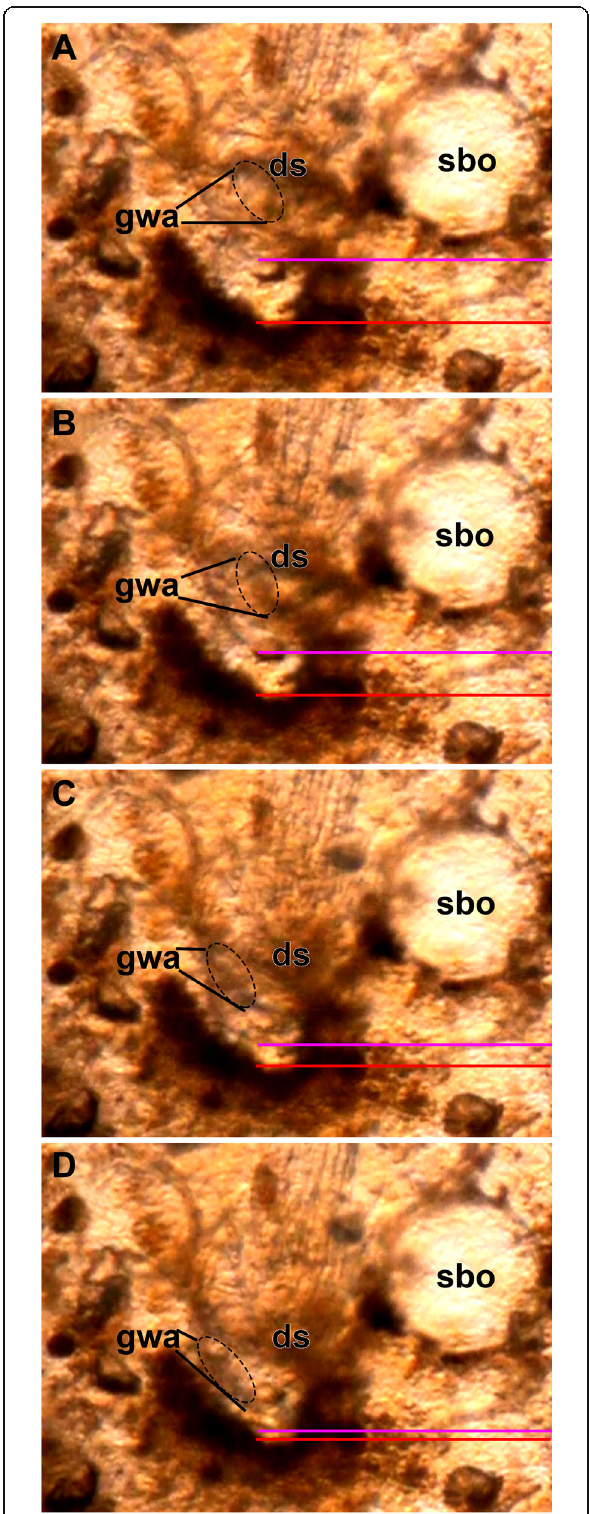
Fig. 7 Sequence of images (from a – d ) taken from Additional file 1 Video S1 showing the eversion of the vestibular wall bearing the gnawing apparatus of Hypophorella expansa . The red line marks the distal border of the borehole created by the bryozoan. The pink line shows the distal border of the vestibular wall as it moves closer to the border of the borehole. Note that the gnawing apparatus is discernable by its distinct brownish appearance. Abbreviations: ds – diaphragmatic sphincter, gwa – gnawing apparatus, sbo